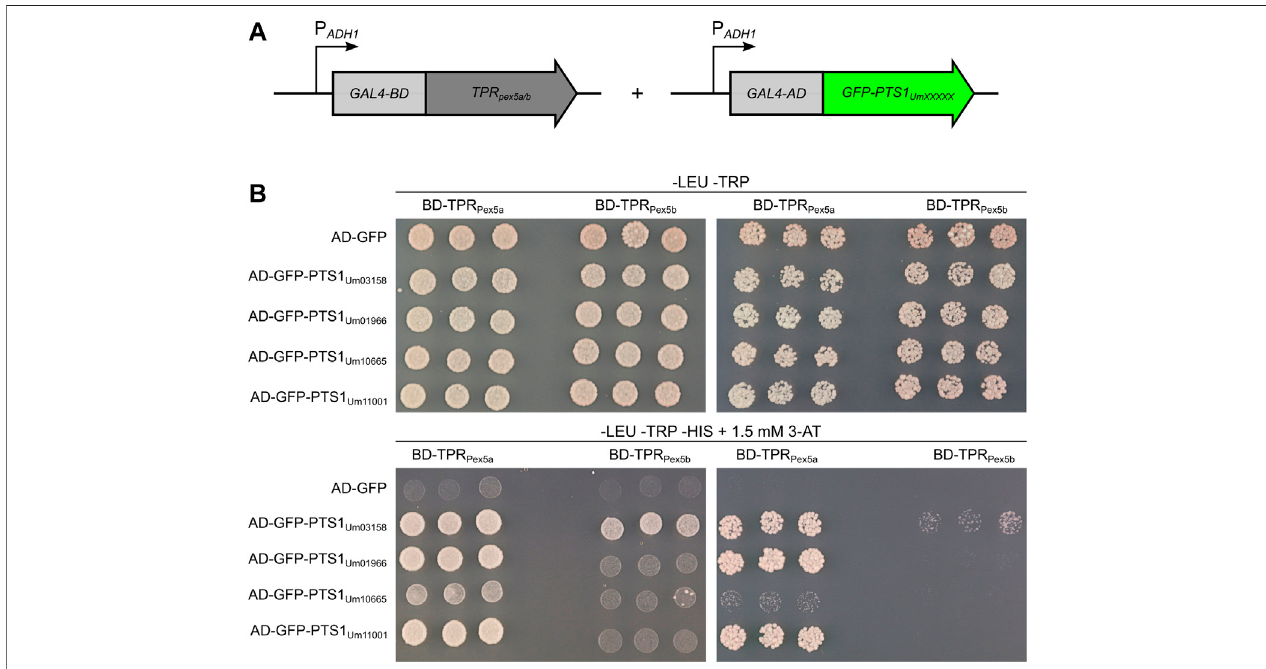
FIGURE 4 | PTS1 motifs with higher af fi nity to Pex5a. (A) Schematic drawing of constructs used for the yeast two-hybrid assay. Constructs were expressed in a strainderivedfromAH109deletedfor PEX5 (Stehliketal.,2020).TPRdomainsofeitherPex5aorPex5bwerefusedtotheGAL4DNA-bindingdomain(GAL4-BD),while C -terminal dodecamers of candidate proteins were fused to the GAL4 activation domain (GAL4-AD). (B) Fivefold and fi ftyfold dilutions (OD 600 = 0.2 and 0.02, respectively)ofthreeindependenttransformantsco-expressingindicatedconstructswerespottedon-LEU-TRPmediaand-LEU-TRP-HISmediaandincubated for 3 days at 30 ° C. The selection medium (-LEU -TRP -HIS) contained 1.5 mM 3-Amino-1,2,4-triazole. This assay demonstrates that Um01966, Um10665 and Um11001 are substrates of the Pex5a TPRs and show only a very weak interaction with the Pex5b TPRs.